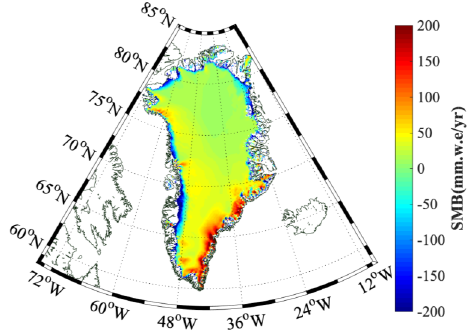
Figure 7. The mean cumulative surface mass balance from the RACMO2.3 model.